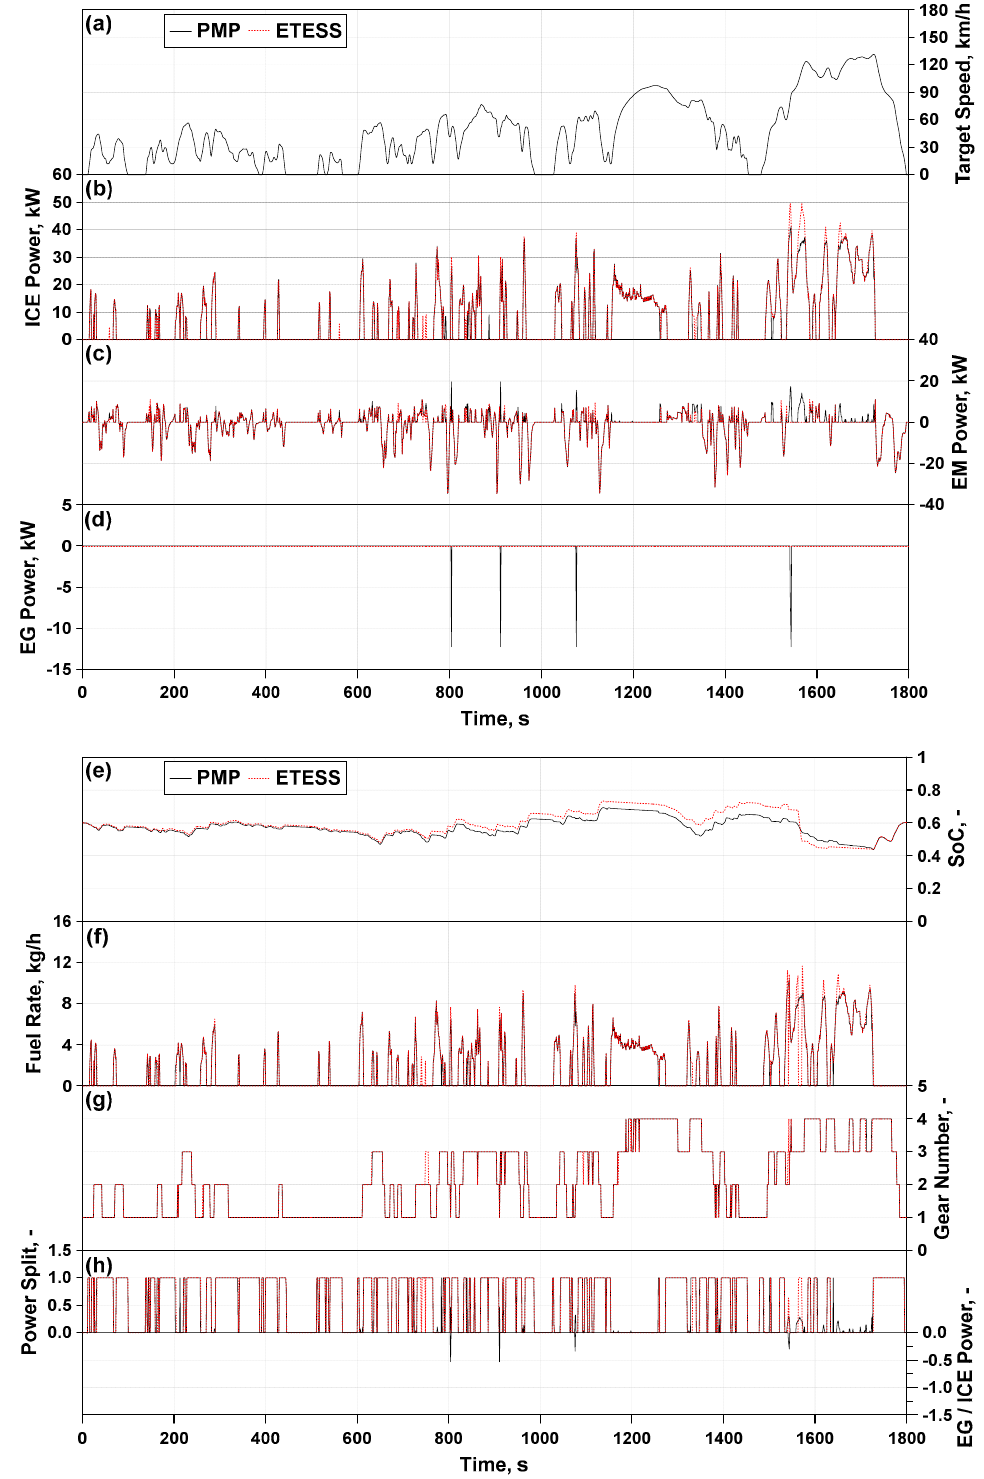
Figure 10. PMP-ETESS comparisons of ICE power ( b ), EM power ( c ), EG power ( d ), SoC ( e ), fuel rate ( f ), GB 1 number ( g ) and vehicle mode ( h ) along the WLTC (vehicle speed—( a ))—case #10.